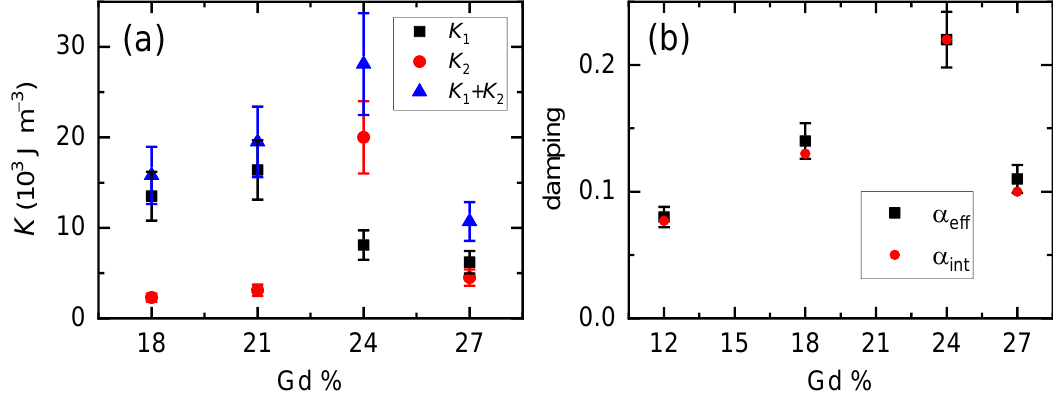
Figure 5. Summary of the uniaxial anisotropy ( K ) and damping constant ( α ). ( a ) The K values of the GdCo alloy. The black square/red circle/blue triangle corresponds to the first order ( K 1 )/second order ( K 2 )/total ( K 1 + K 2 ) anisotropy. The error range in the K 1 and K 2 determination is 20% considering the 10% uncertainty in M S of VSM measurements and ± 1 ◦ error in θ H of AHE measurements. ( b ) The α values of the GdCo alloy. The black square/red circle corresponds to the effective damping ( α eff )/intrinsic damping ( α int ). The α eff is obtained from the fitting of the precession motion. The α int is obtained using Equation (4) for the Gd = 12%, 18%, and 27%. For the Gd = 24%, we assume α int is the same as α eff . The error range in the α eff determination is 10% considering the fitting uncertainties of f and τ